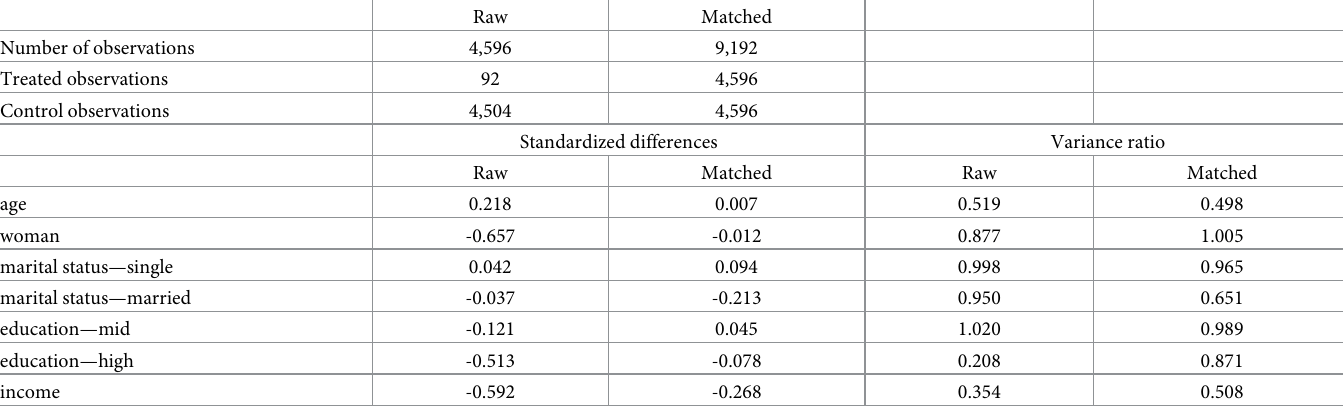
Table 7. Covariate balance summary BMI matching 6